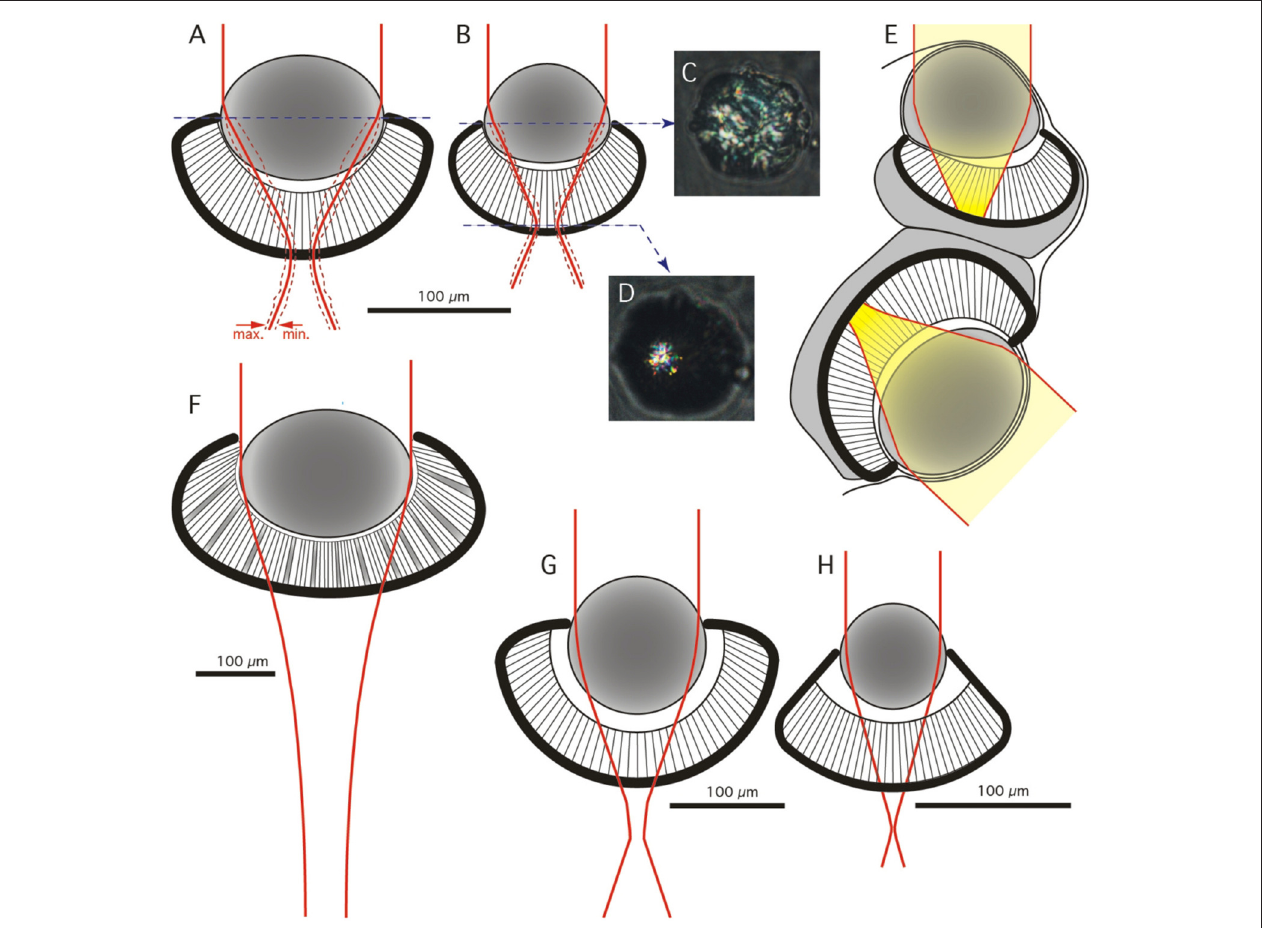
FIGURE 2 | Geometrical model and optics of the lens eyes. (A,B) Frontal view of anatomical models of the lower (A) and upper ( B ) lens eye of C. sivickisi . Red line indicates average beam width of a distant point light source, broken red lines indicate maximum and minimum beam width ( N = 5 in A and N = 3 in B) . (C,D) Examples of the appearance of beam cross-sections behind a lens of the upper lens eye photographed at the lens equator and at the focal plane. (E) The average beam profilers from (A,B) plotted in the sagittal plane of the rhopalium. The yellow field highlights beam width for a point source and thus the blur spot in the retina. (F) Optical model of the lower lens eye of Chiropsella bronzie for comparison (modified from O’Connor et al., 2009). (G,H) Optical models of the lower and upper lens eyes of Tripedalia cystophora respectively (modified from Nilsson et al.,